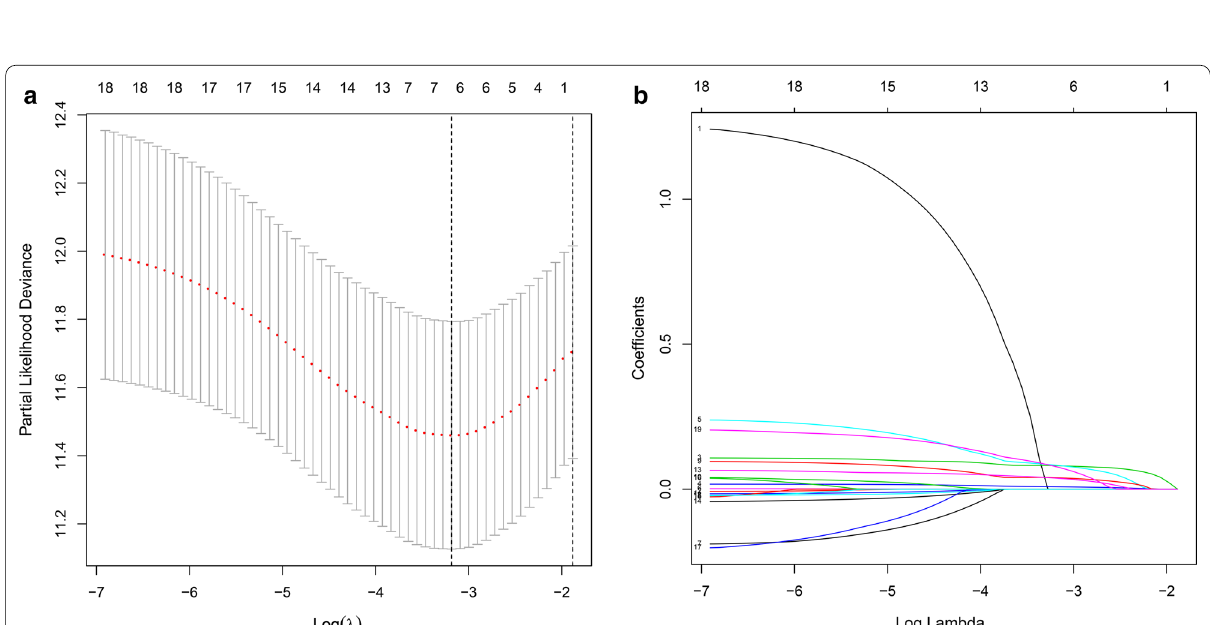
Fig. 4 The LASSO regression analysis applied to screening RBPs that optimal used for the construction of the gene signature. a Screening of optimal parameter (lambda) at which the vertical lines were drawn. b LASSO coefficient profiles of the 6 RBPs with non-zero coefficients determined by the optimal